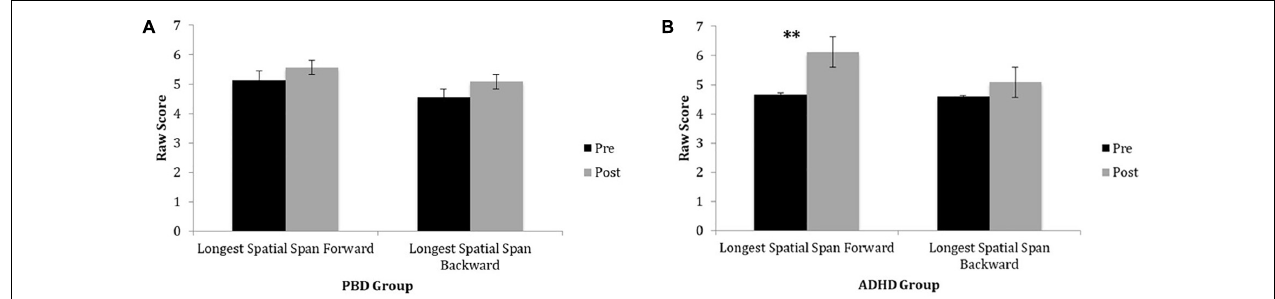
FIGURE 2 | Spatial Span Task performance in PBD and ADHD before and after Cogmed training. (A) Bar graph representing raw scores for the PBD group. (B) Bar graph representing raw scores for the ADHD group. PBD, pediatric bipolar disorder; ADHD, attention deficit-hyperactivity disorder; Pre, pre-training scores; Post, post-training scores. ∗∗ p < 0.01.